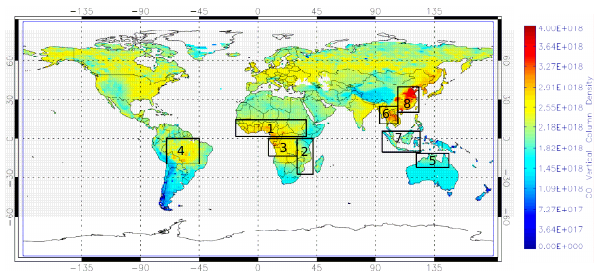
Fig. 8. Mean CO VCD retrieved from SCIAMACHY (2003 to 2005, units: moleccm − 2 ) . The boxes indicate regions of high biomass burning or industrial activity that are selected for the com- parison between satellite observations and model simulations (see Sect.